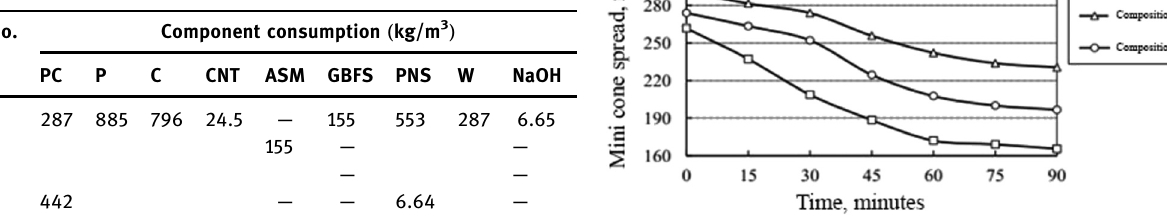
Figure 14: Change in fl owability of nano - modi fi ed concrete mixtures